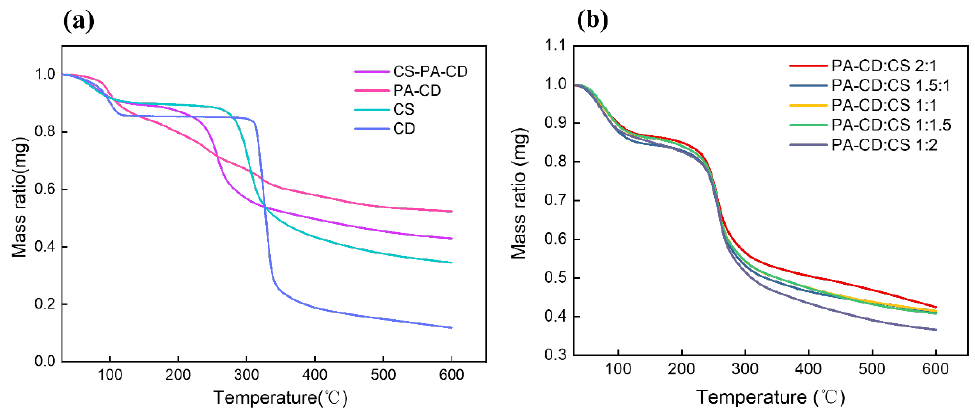
Figure 3. TGA curves of ( a ) different samples (PA-CD:CS, 1:1) and ( b ) CS-PA-CD nanoparticles with different ratios of PA-CD to CS.